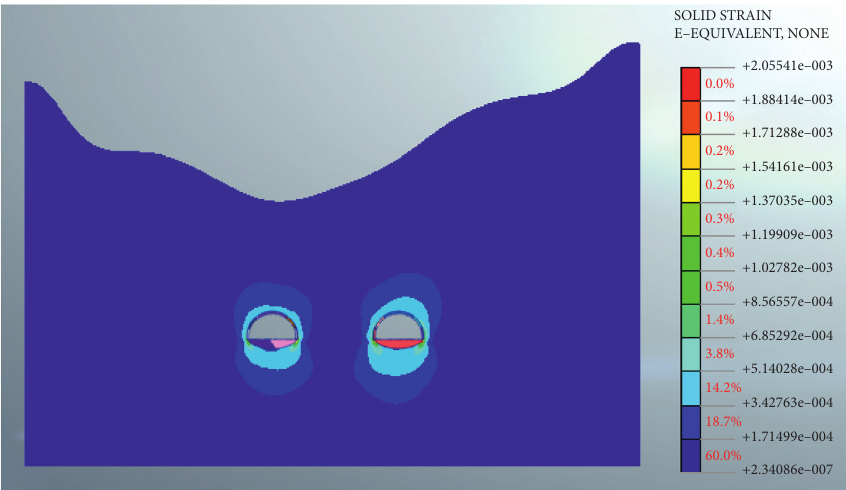
Figure 10: Distribution of plastic area in double-side guide pit method.